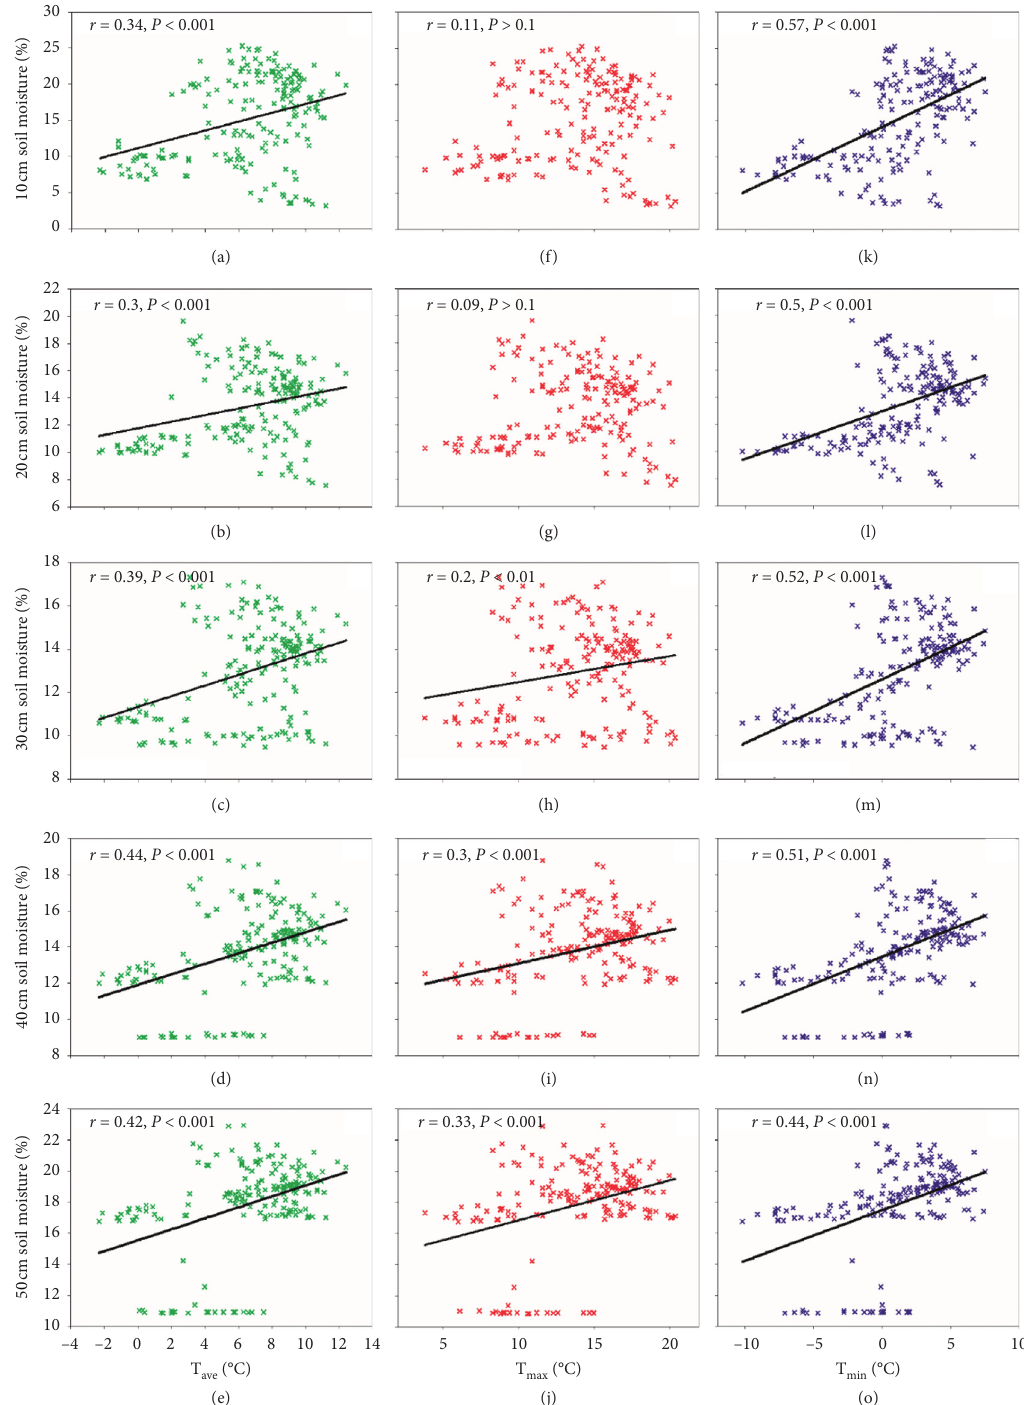
Figure 4: Correlations between air temperature and soil moisture at